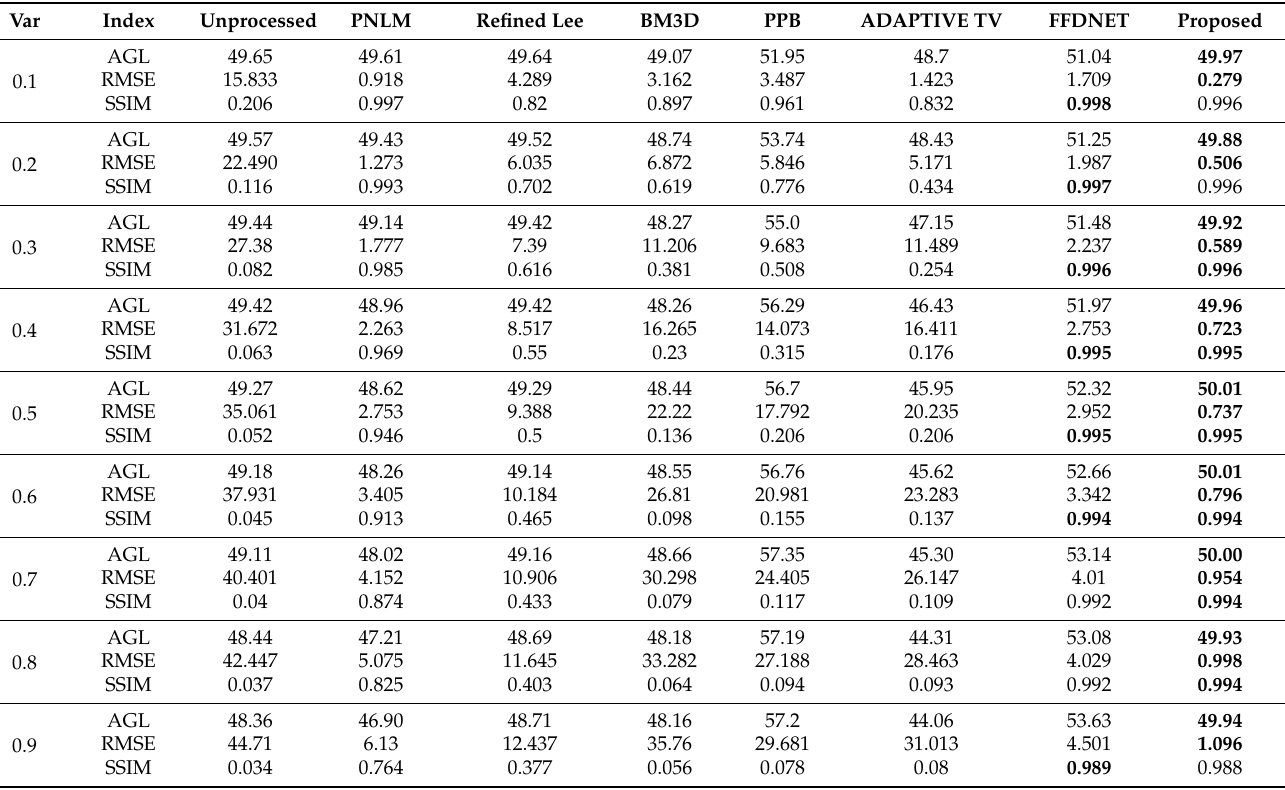
Table 3. Data statistics of nine gray pictures.